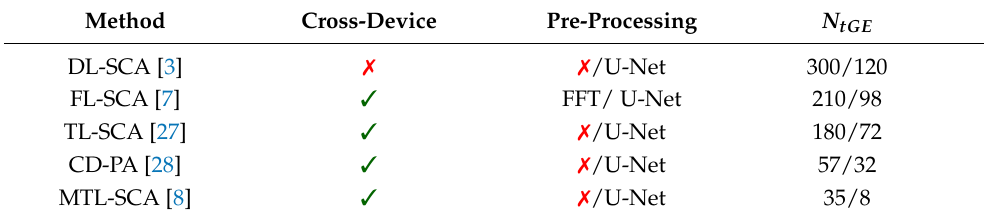
Table 3. A comparison to related works with/without our U-Net-based denoising model. N tGE represents the number of traces required to recover the secret key from the target device (on average). FFT—Fast Fourier Transform.